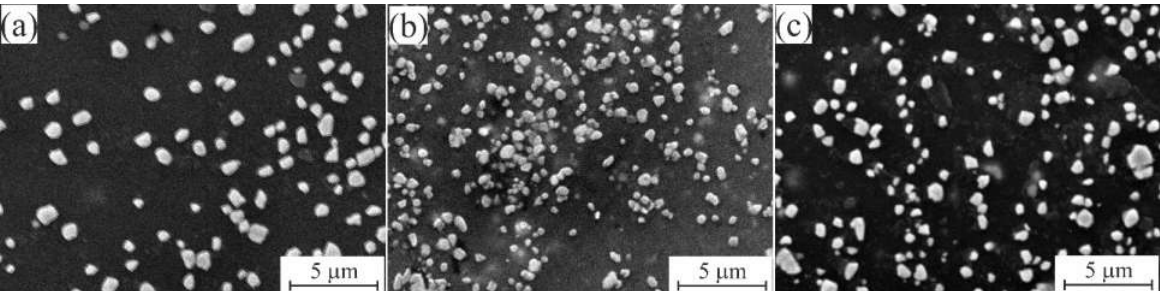
Figure 4. SEM micrographs of the manufactured composites reinforced with: ( a ) mono-reinforcement (VC), ( b ) hybrid-reinforcements (VC + BN), and ( c ) triple-reinforcements (VC + BN + GNPs).